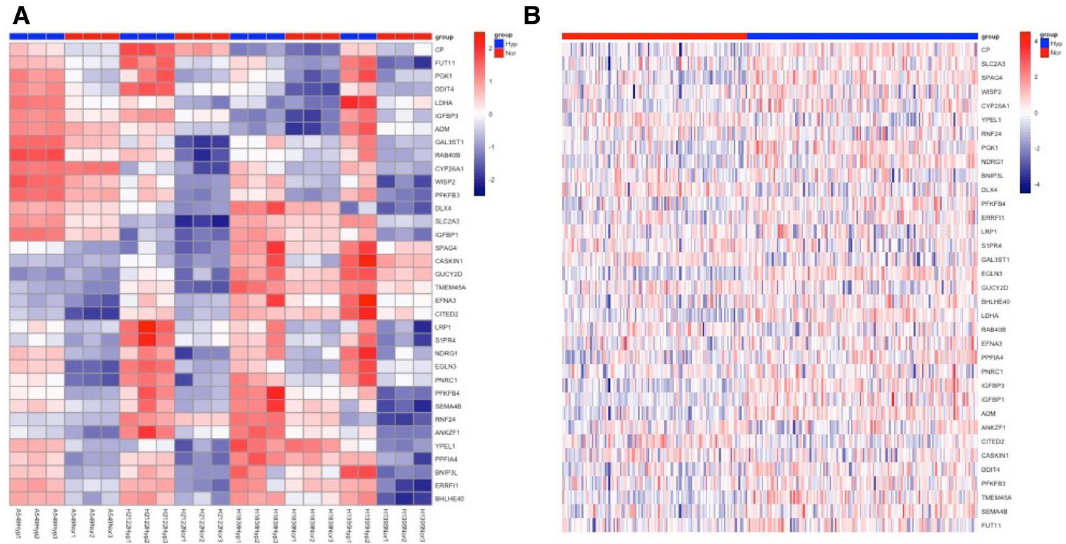
Figure 1. Genes clustered into hypoxia and normoxia phenotypes based on expression similarity of 35 seed genes used to develop the LUAD hypoxia-associated signature. Heatmaps are shown for four LUAD cell lines cultured in 1% O 2 and 21% O 2 ( A ) and 252 samples from the TCGA LUAD training dataset ( B ). TCGA LUAD The Cancer Genome Atlas lung